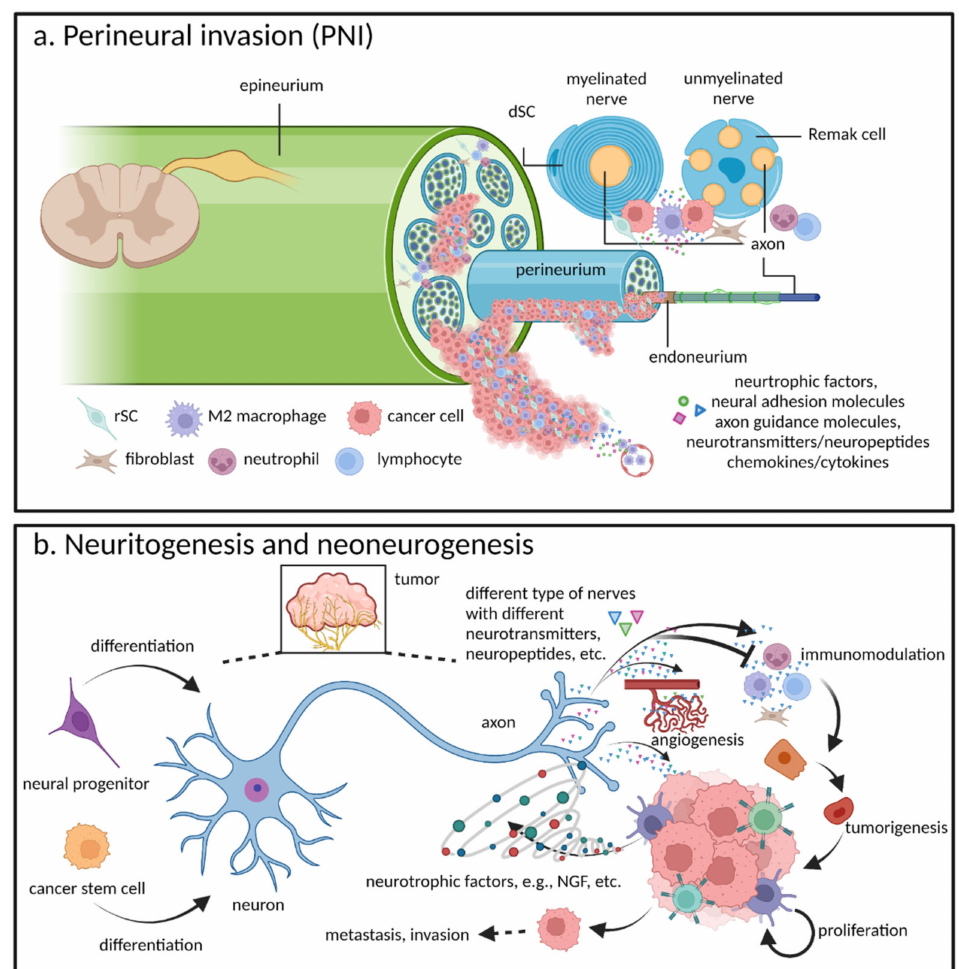
Figure 1. An illustration of the multiple means of pathogenesis involved in cancer–nerve crosstalk: ( a ) Macrophages, Schwann cells, fibroblasts, immunocytes, and other stroma cells have been reported to be involved in perineural invasion (PNI), where multiple neurotropic, neuroadhesion, axon guid- ance factors, neurotransmitters/neuropeptides, and cytokines/chemokines participate in cellular interactions; ( b ) Induced and promoted by cancer cells, neuritogenesis promotes tumorigenesis and cancer progression by directly activating cancer cells or inducing angiogenesis, modulating the im- munomicroenviornment, and so forth through means of multiple neurotransmitters or neuropeptides. Neoneurogenesis occurs when neural progenitors (or, in some instances, cancer stem cells) differenti- ate to mature neurons and is followed by tumor-induced neuritogenesis. rSC: repair Schwann cell (or dedifferentiated Schwann cell); dSC: differentiated Schwann cell; NGF: neural growth